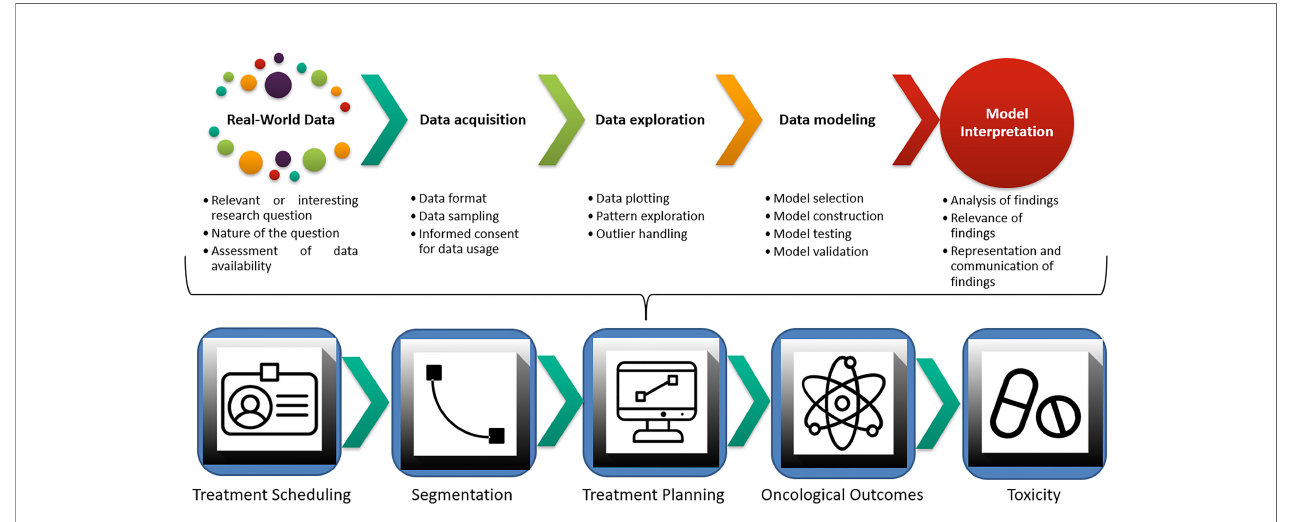
FIGURE 1 | Machine learning work fl ow and current applications in Radiation